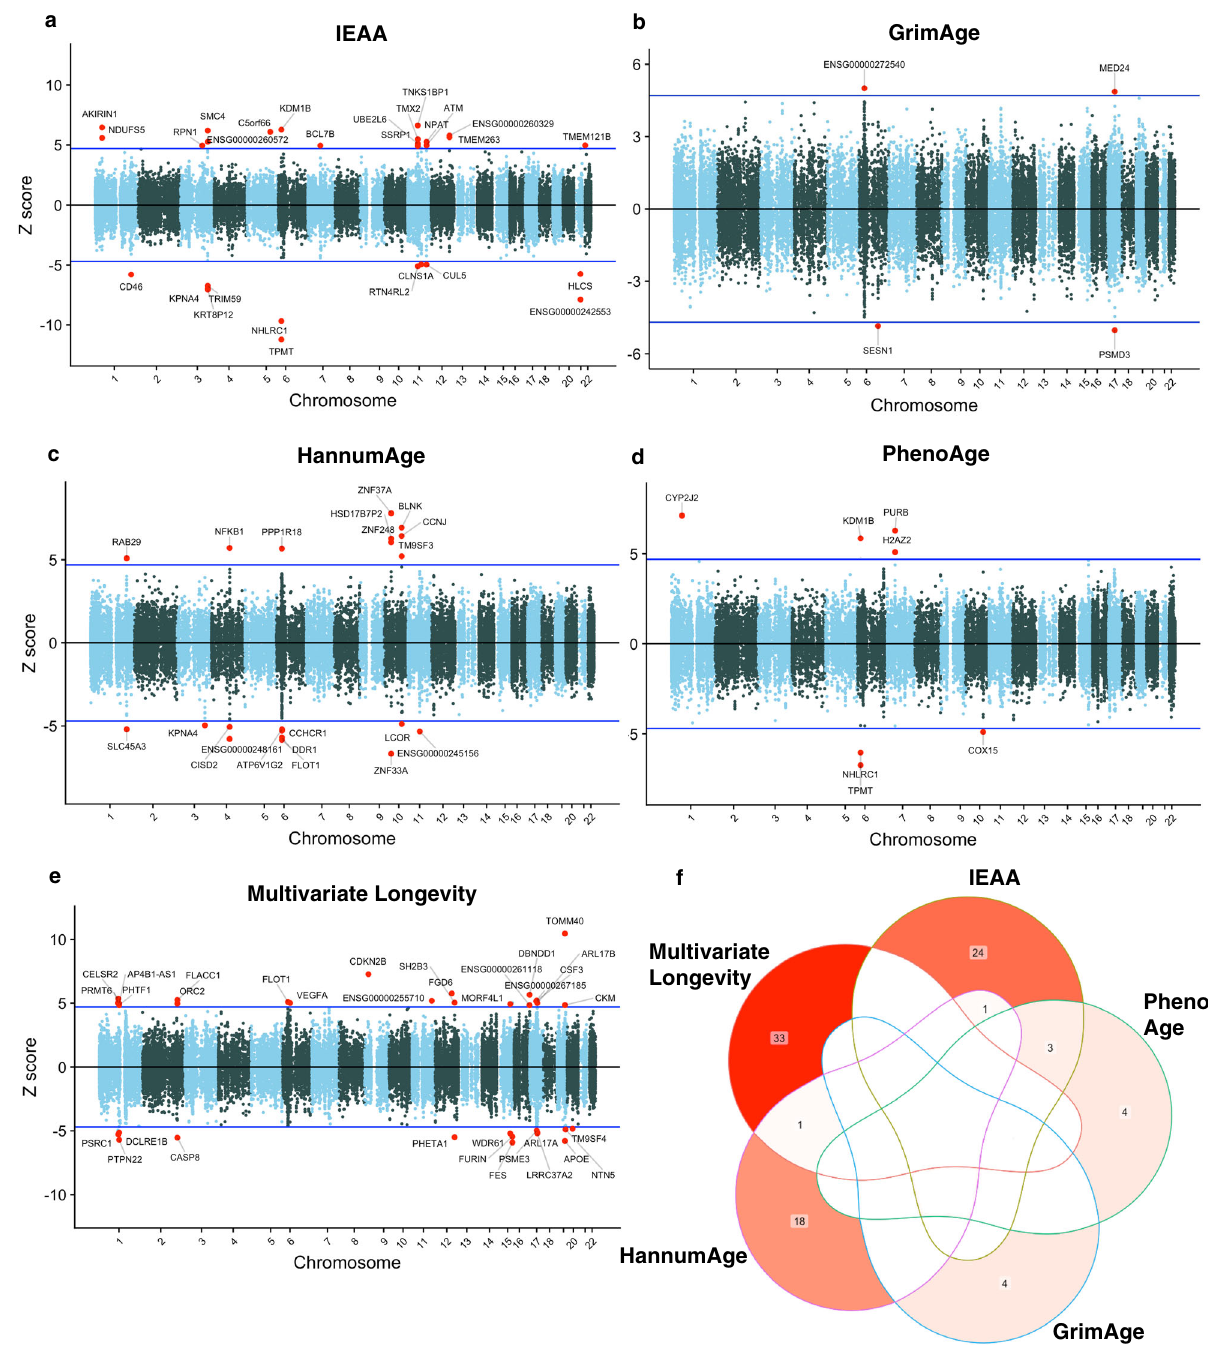
Fig.2|ResultsofTWASsofEAAandmultivariatelongevity.a – e Manhattanplots of gene-traits associations for aging-related traits (IEAA, GrimAge, HannumAge, PhenoAge, multivariate longevity). X axes represent genomic position. Blue lines represent Z =4.837, which corresponds to a Bonferroni-corrected signi fi cance threshold of P =1.32×10 − 6 . Red circles represent statistically signi fi cant gene-trait